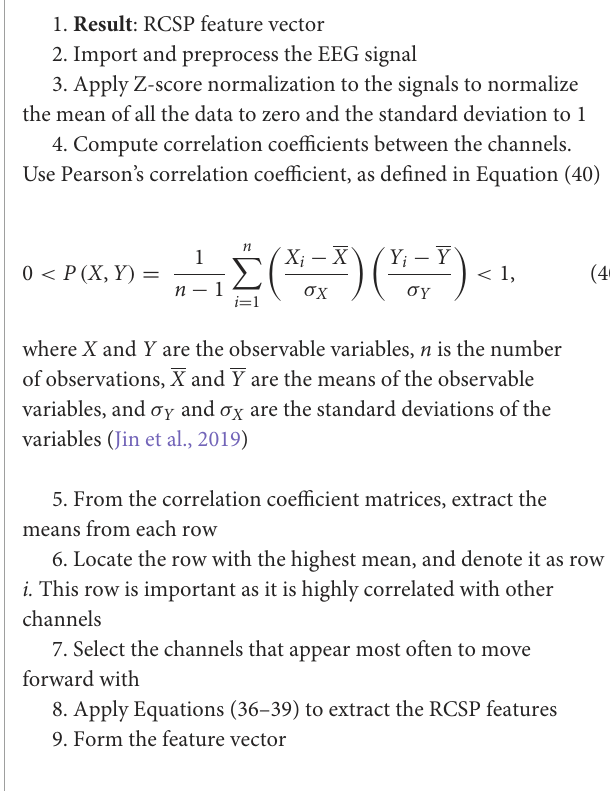
Algorithm 20. RCSP algorithm (Jin et al., 2019).